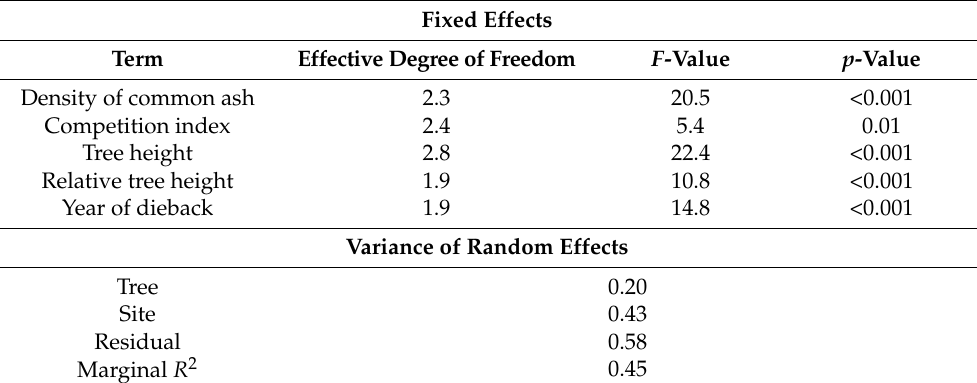
Table 2. Effective degree of freedom, their F -values and significance ( p -values), as well as the variance of random